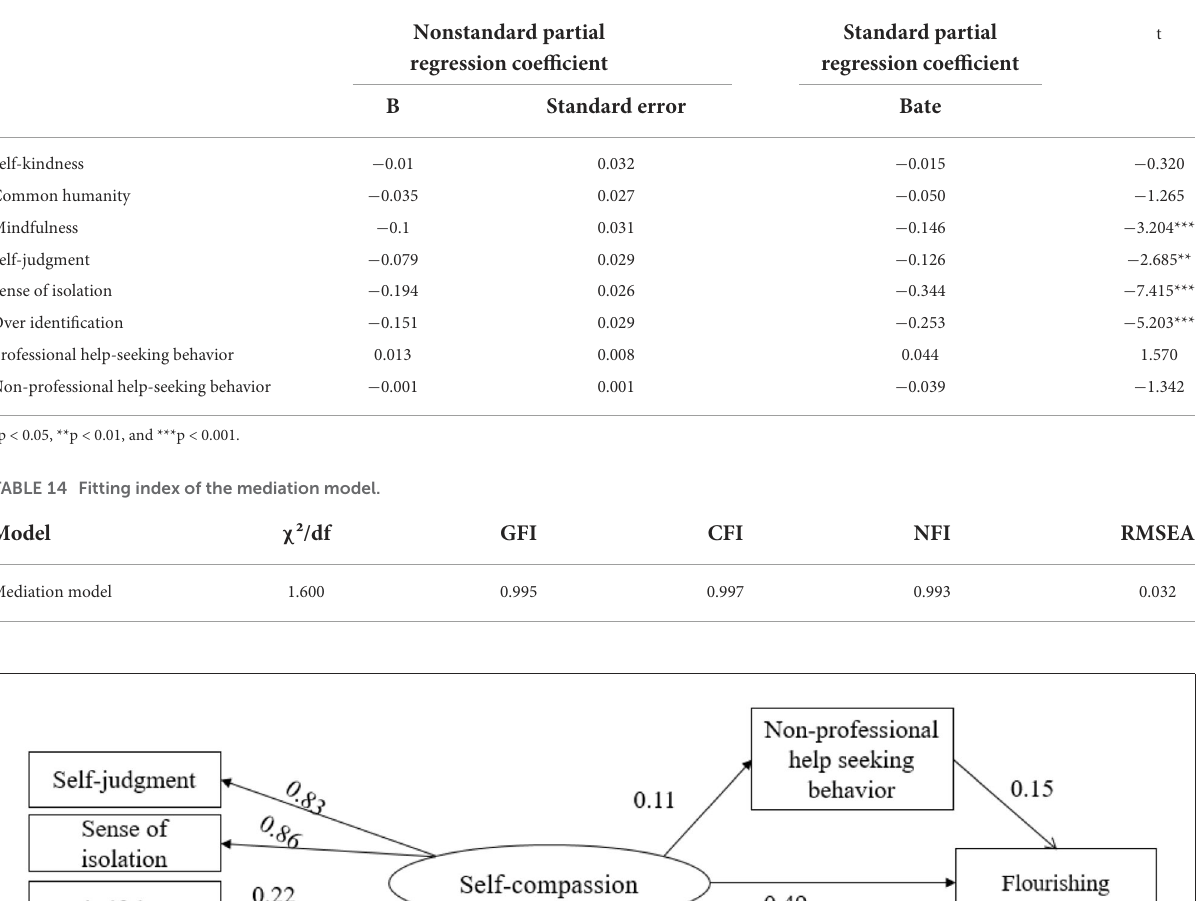
TABLE 13 Model coefficients of internalization problems.